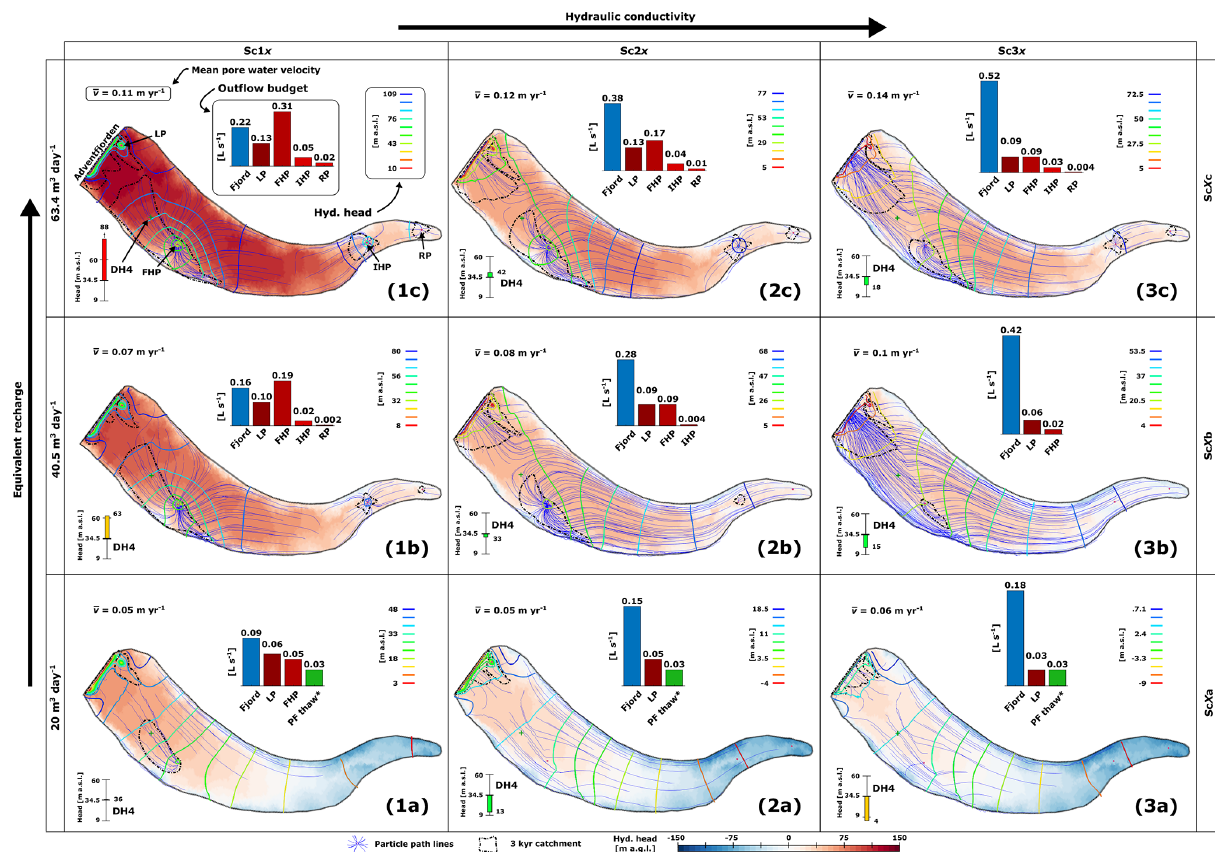
Figure 8. Groundwater model simulations from all nine scenarios. The individual diagrams are sorted so that the hydraulic conductivity increases along the right-hand axis (scenarios Sc1–3 x ) and the equivalent recharge produced by permafrost aggradation increases along the left-hand axis (scenarios Sc X a–c). On each diagram, the following simulation results are illustrated: heads from the uppermost grid layer are shown in metres above sea level (ma.s.l.) by isopotential contours (note that the colour scales are different) and in metres above ground level (ma.g.l.) by the colour fill (see scale at the bottom of the figure). The latter indicates if artesian conditions are simulated (reddish) or not (blueish). The groundwater outflow rates and distribution are illustrated by bar charts with the location of the discharge points (pingos and fjord) indicated in (1c) . For minimum Q R scenarios (1a, 2a, 3a) , part of the outflow represents phase change associated with permafrost Eq thaw (Fig. 7b–c), which causes a storage redistribution within the model domain. Flow patterns are illustrated by thin blue lines which each depict pathways of particles released in the uppermost grid layer. The mean pore water velocities, shown in the upper left-hand corners, were calculated from the aforementioned particles and using the same porosities for all scenarios (Table 3). The thick dashed lines outline the areas (catchments) that contributed water to the outlet points during 3 kyr of simulation time. In the lower right-hand corner, the simulated head in well DH4 is illustrated on a range plot with the range defined like that deduced from Braathen et al. (2012). The colour of the bar indicates if the simulated head falls within (green) or outside the deduced range with less (yellow) or more (red) than 10% of the total range. The location of DH4 and the pingo springs is marked in (1c)